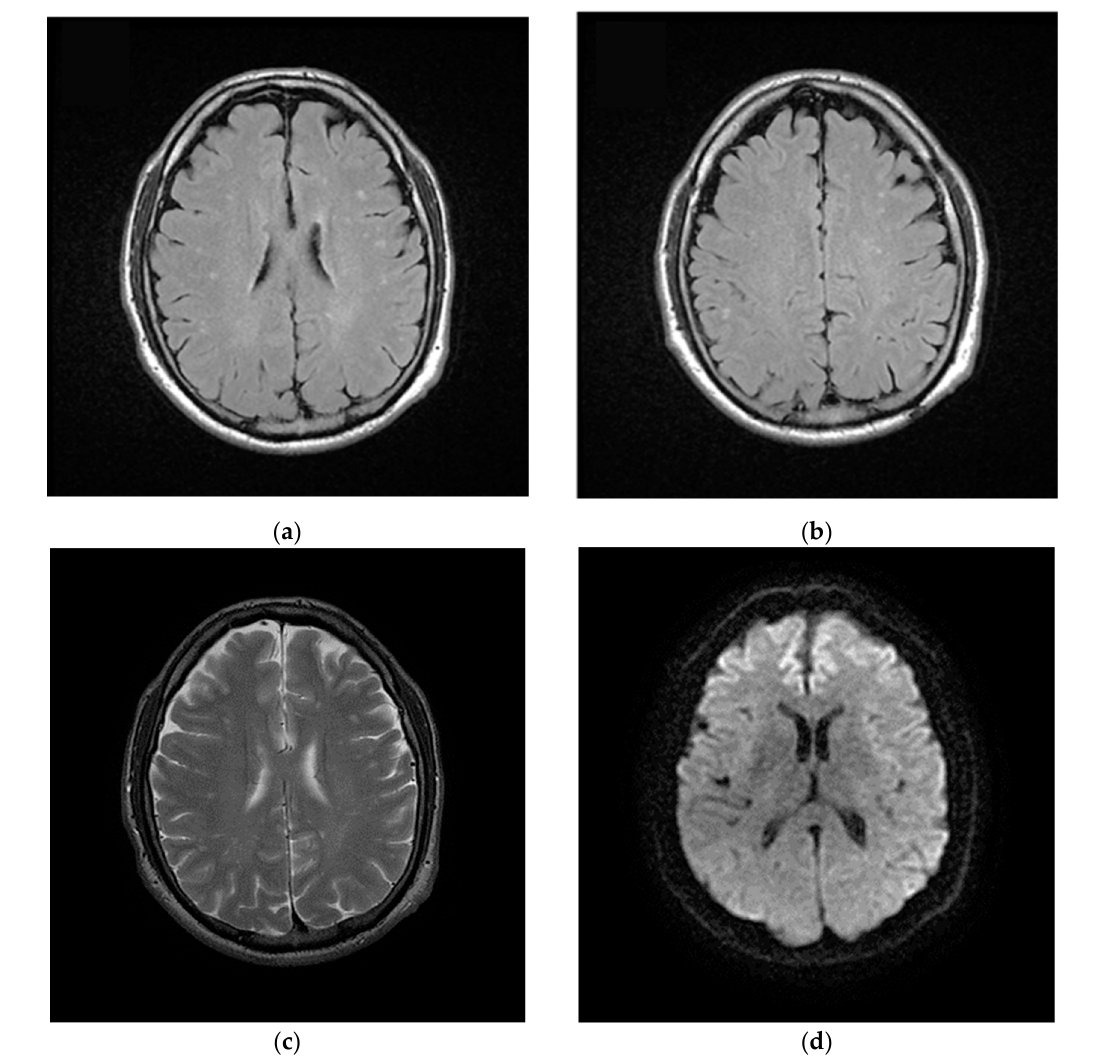
Figure 4. Magnetic Resonance Imaging (MRI) of brain after discharged from the hospital. ( a , b ) Axial FLAIR and ( c ) axial T2w images show nonconfluent multifocal white matter hyperintense lesions; ( d ) On axial diffusion weighted image (DWI) the same lesions do not show impeded diffusion. These lesions were referred to gliotic outcomes. Table 1. Anthropometric measure from pre to post infection. Abbreviations: 6-Minute Walking Test (6-MWT); Body Mass Index (BMI).